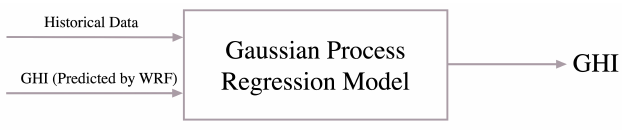
Figure 4. The layout of the hybrid prediction regression